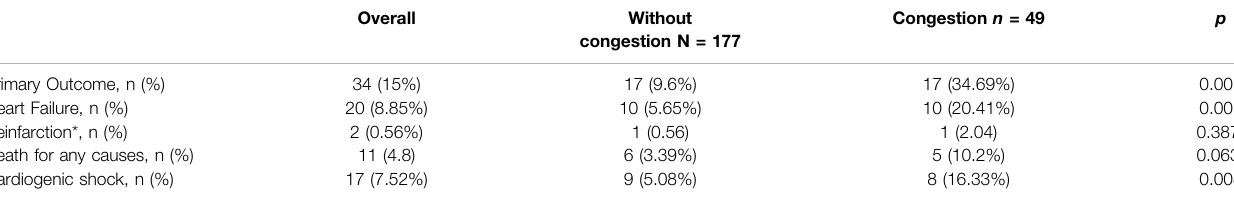
TABLE 2 | Outcomes in patients with ST-segment elevation myocardial infarction and pulmonary congestion assessed by LUS.